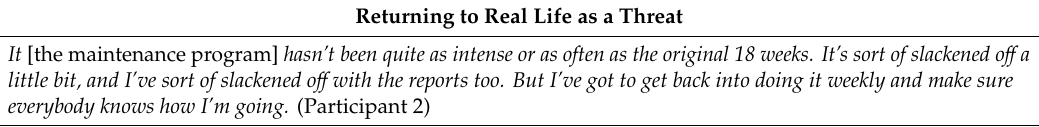
Table 2. Quotes supporting the context of weight loss maintenance for the participant.